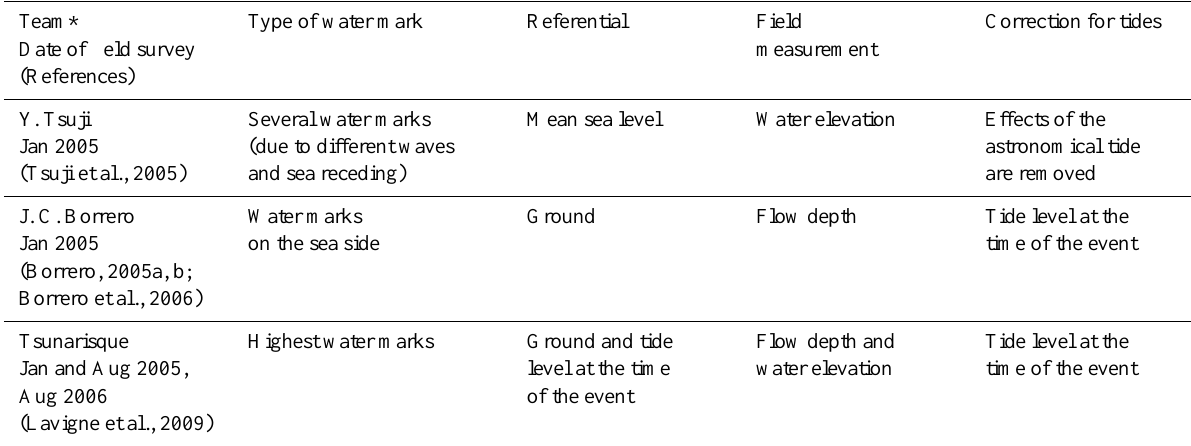
Table 1. Summary of the three analyzed field surveys which were conducted in Banda Aceh (Indonesia) after the December 2004, Indian Ocean